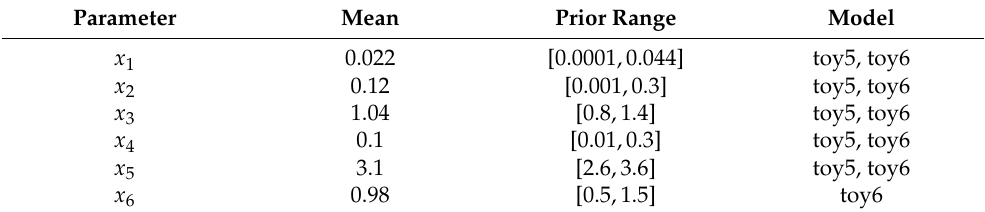
Table 1. The parameters used in the analytical evaluation of the toy model evidences, with five and six parameters, respectively. The maximum likelihood of the toy models is taken (arbitrarily) to be L max = 1. Parameter Mean Prior Range Model x 1 0.022 [0.0001,0.044] toy5, toy6 x 2 0.12 [0.001,0.3] toy5, toy6 x 3 1.04 [0.8,1.4] toy5, toy6 x 4 0.1 [0.01,0.3] toy5, toy6 x 5 3.1 [2.6,3.6] toy5, toy6 x 6 0.98 [0.5,1.5]